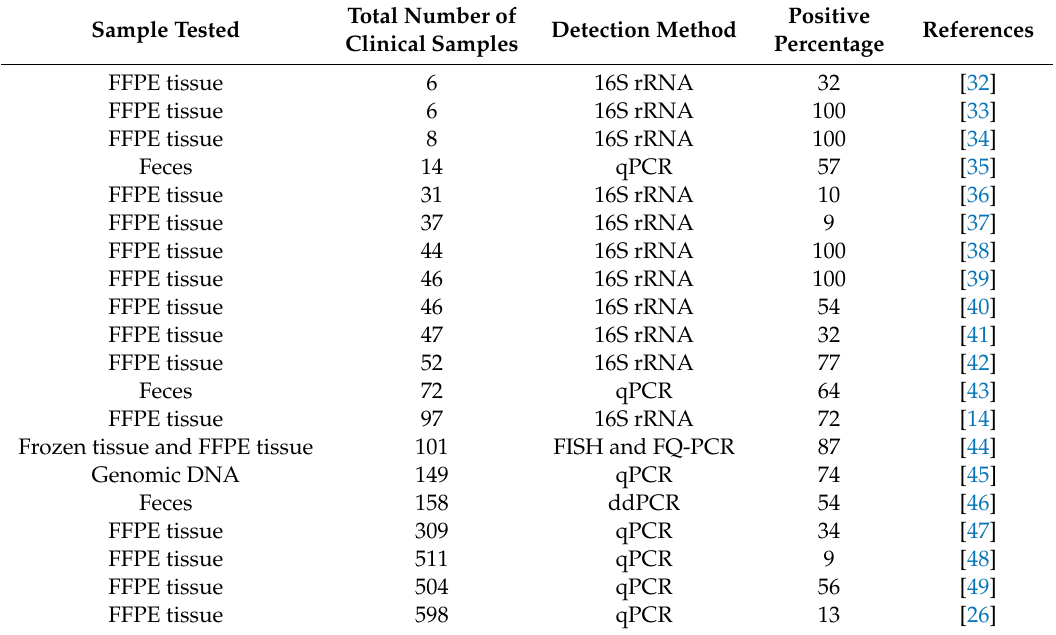
Table 1. Detection of F. nucleatum in colorectal cancer (CRC)